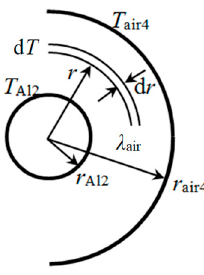
Figure 13. Heat flow from the interior through the air layer.